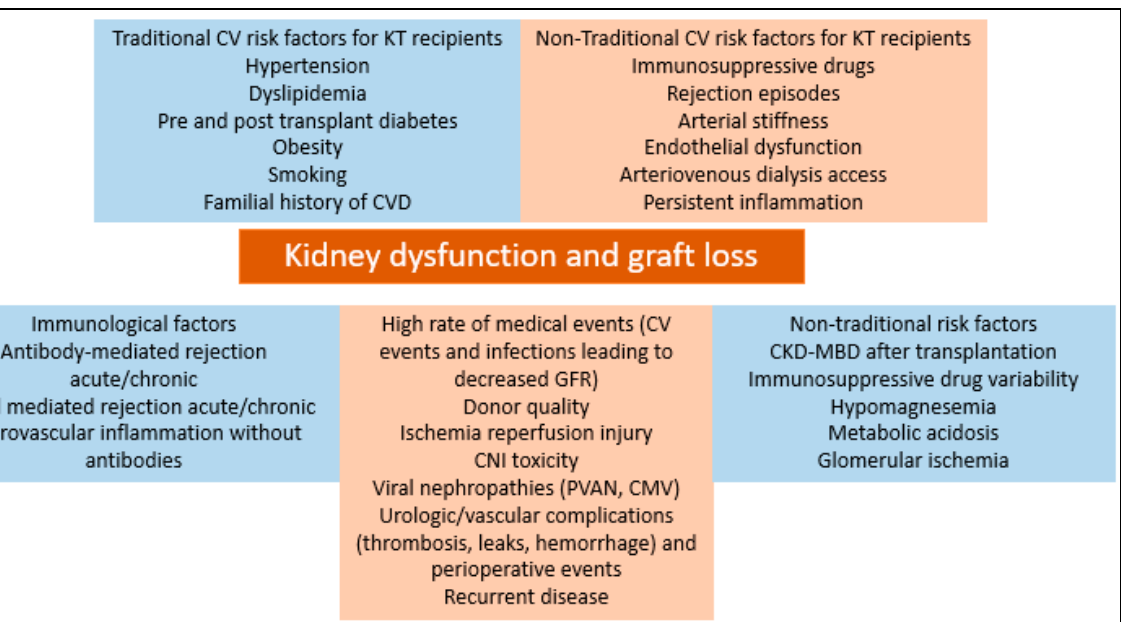
Figure 2. Risk factors for kidney dysfunction and allograft loss in kidney transplant recipients.